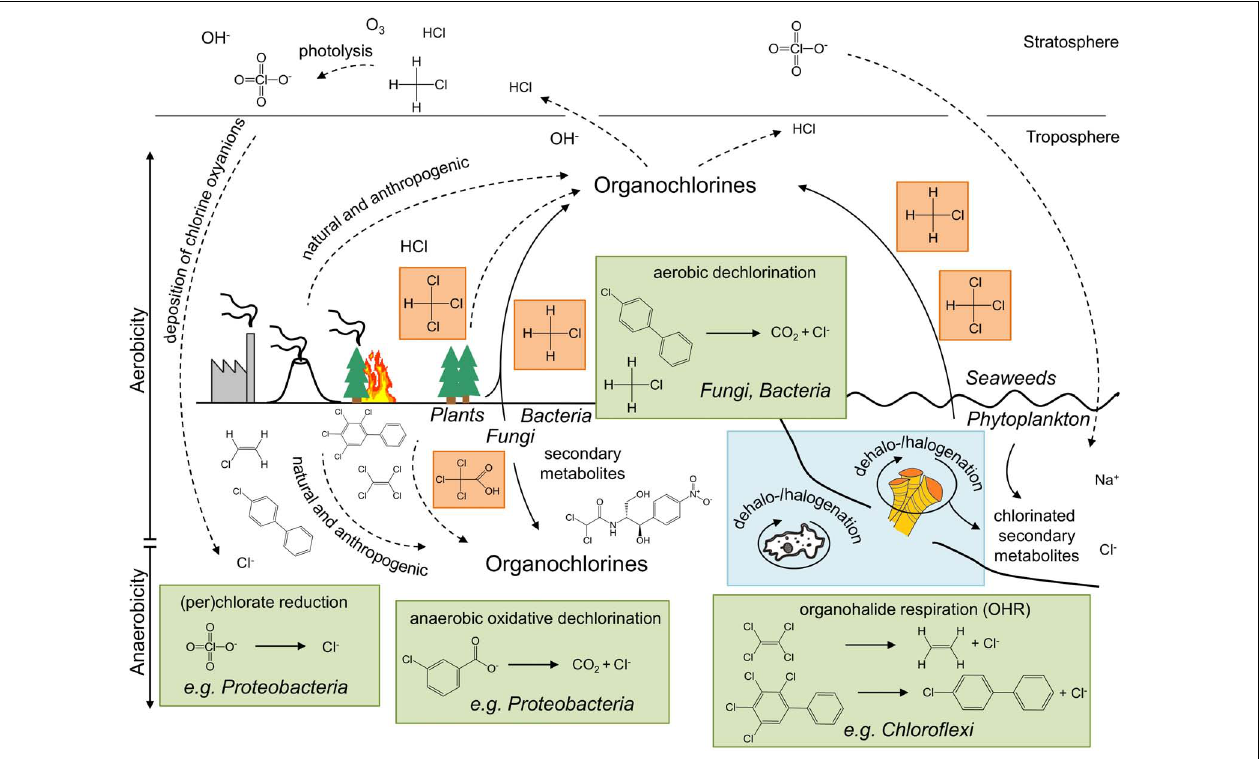
FIGURE 1 | Selected chlorine compounds, their origin and (bio)transformation – a schematic overview of the global chlorine cycle. Representative microbial dechlorination processes and involved compounds are shown in green boxes. The most abundant biologically produced chlorine compounds are indicated in orange, whereas examples for local “microcycles” are highlighted in blue. Groups of (micro)organisms associated with a particular metabolism are indicated in italics. Solid and dotted lines illustrate biological and chemical processes,